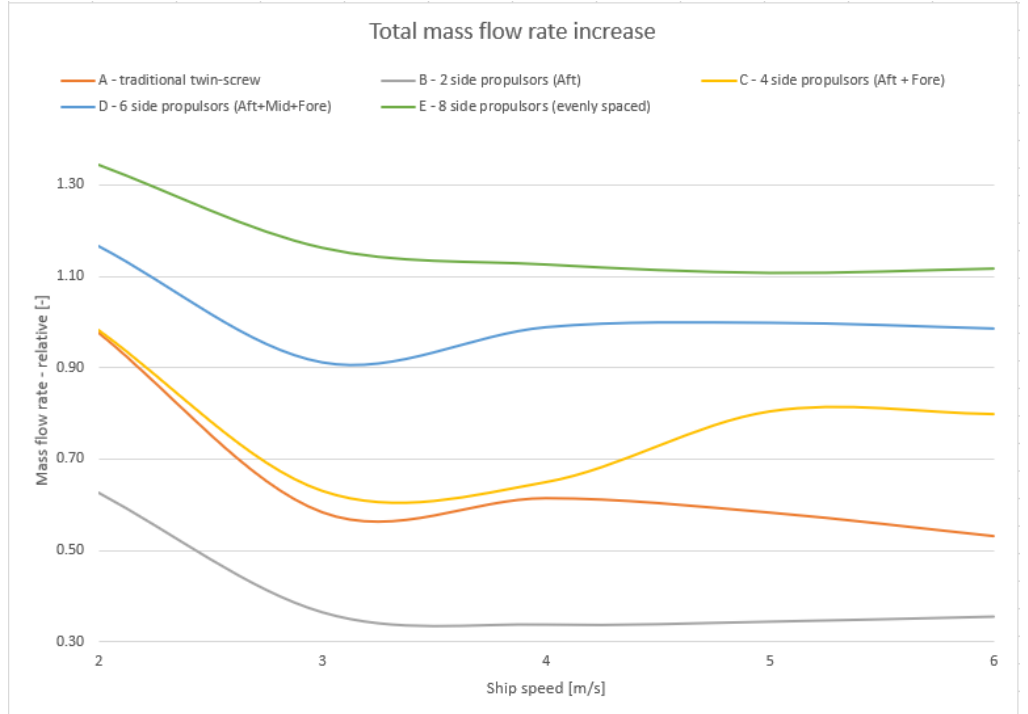
Figure 6. Total mass flow rate, deep water (comparison). Source: Authors.